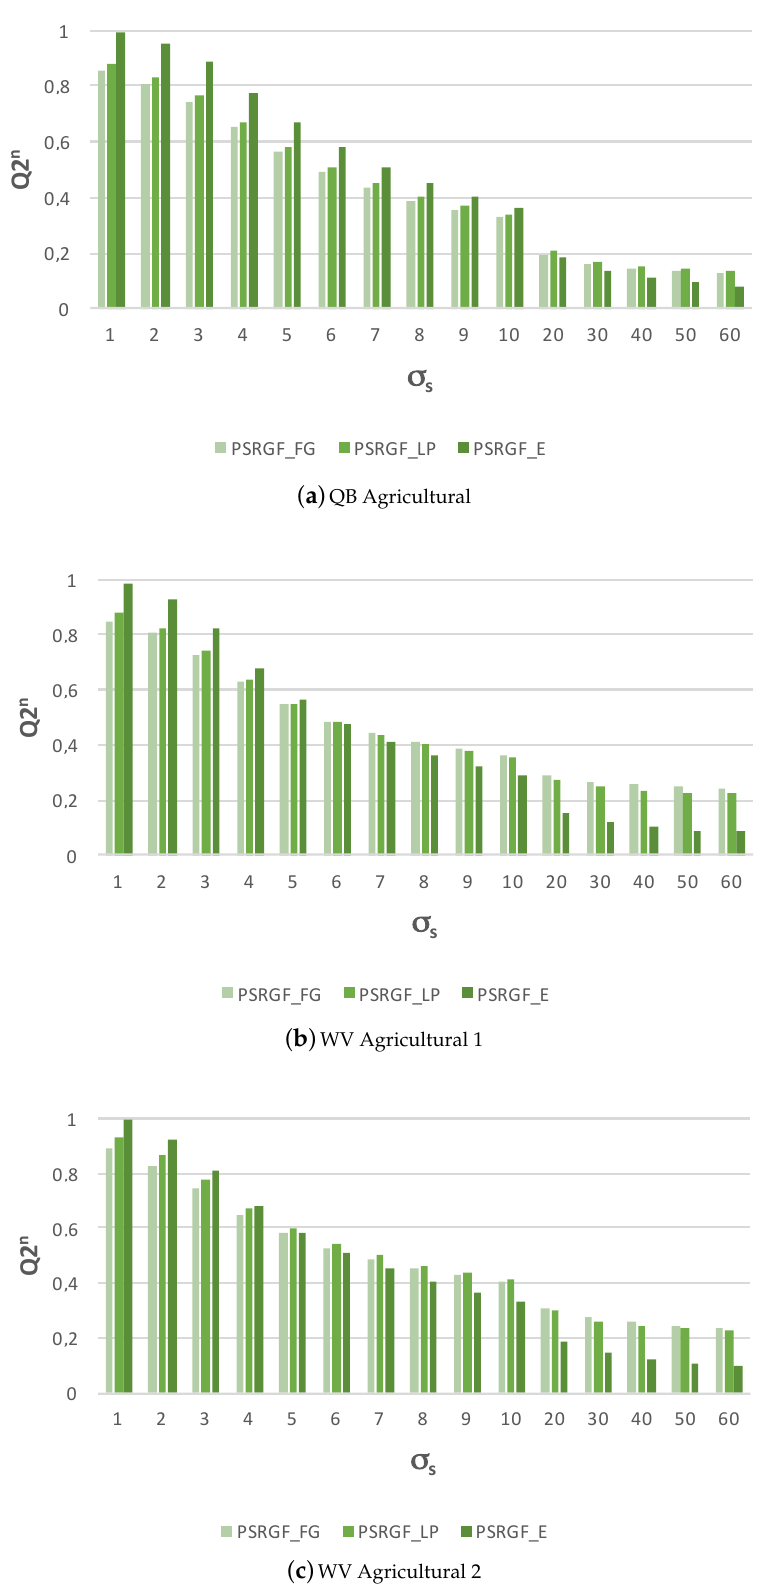
Figure 4. Q2 n index behavior: ( a ) PSRGF FG ; ( b ) PSRGF LP and ( c ) PSRGF E methods for different σ s